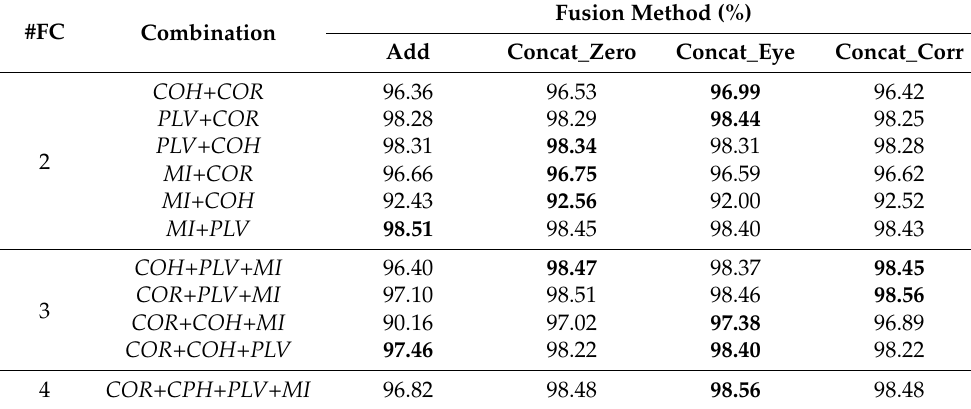
Table 2. Classification accuracy by using single FC (COR, COH, PLV, and MI). Table 3. Classification accuracy by combining multiple FCs with different fusion methods.